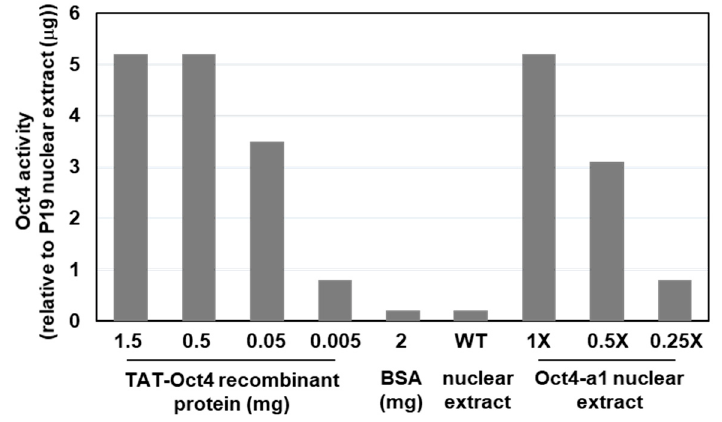
Figure 5. Analysis of the biological activity of rhOct4. The biological activity of rhOct4 was deter- mined in cellular protein extract from Oct4-a1 suspension cells sugar-starved for one day. An oligonu- cleotide containing the Oct4 consensus binding site was incubated with three different dilutions of Oct4-a1 cellular protein extracts. Commercial TAT-Oct4 derived from E. coli cells was used as a reference standard, ranging from 0.005 to 1.5 mg. Two milligrams of bovine serum albumin (BSA) and wild-type rice nuclear extract (WT) were used as negative controls. The Oct4 DNA-binding activity was relative to the positive control (P19 nuclear extract).